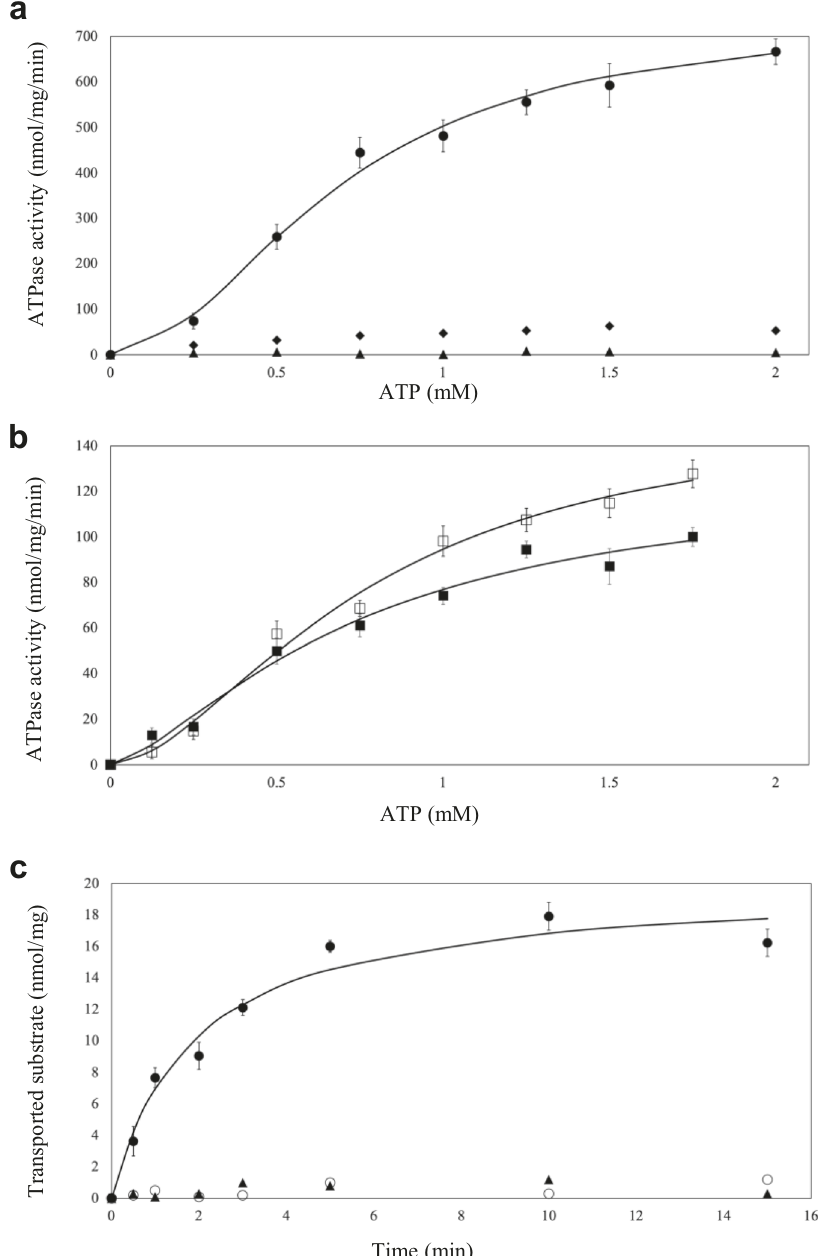
Fig. 1 Functional characterization of the Fhu importers in proteoliposomes. a , b ATPase activity of FhuCB plotted against ATP concentrations. c Substrate transport activity of FhuCB in proteoliposomes. The samples are FhuCB ( ● ), vanadate inhibited FhuCB ( ◆ ), E173A ATPase null-mutant FhuCB ( ▲ ), FhuCB with ferrichrome-loaded FhuD ( ⎕ ), FhuCB with FhuD ( ⎕⎕ ), and FhuCB transport in the absence of FhuD ( ○ ). Error bars are the standard deviation from n = 3 independent